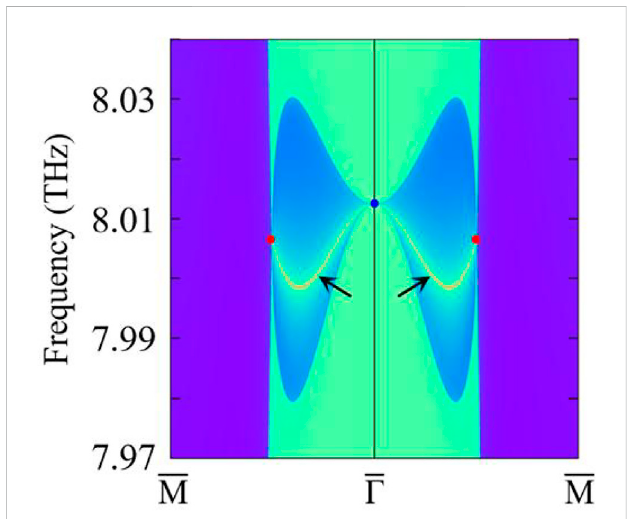
FIGURE 4 The phonon LDOS projected on the (001) surface. The phonon surface states are marked by black